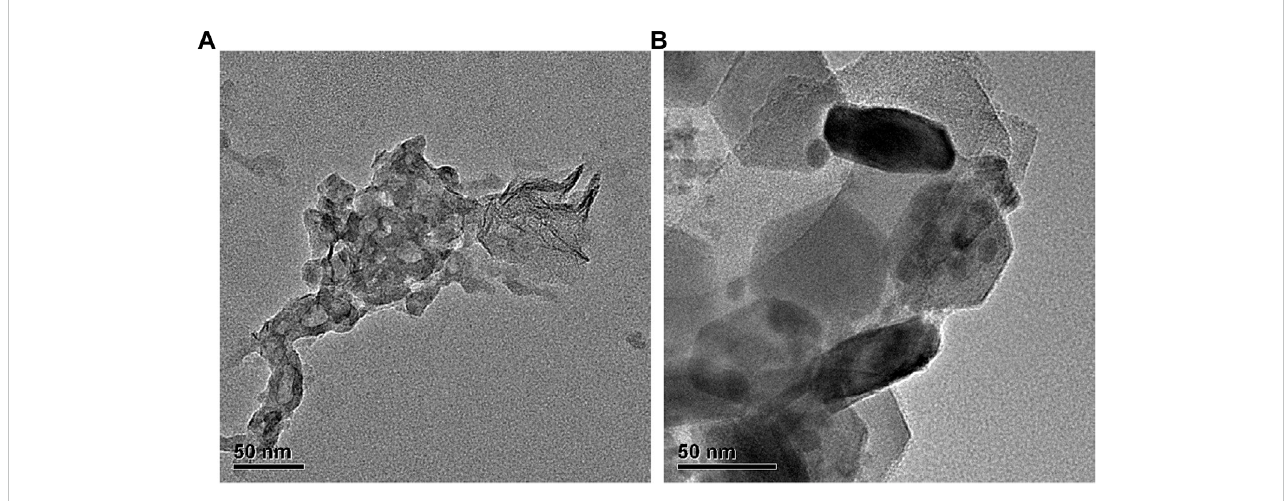
FIGURE 3 Scanning electron microscope image of TWPs. Scale bar, 50 nm.